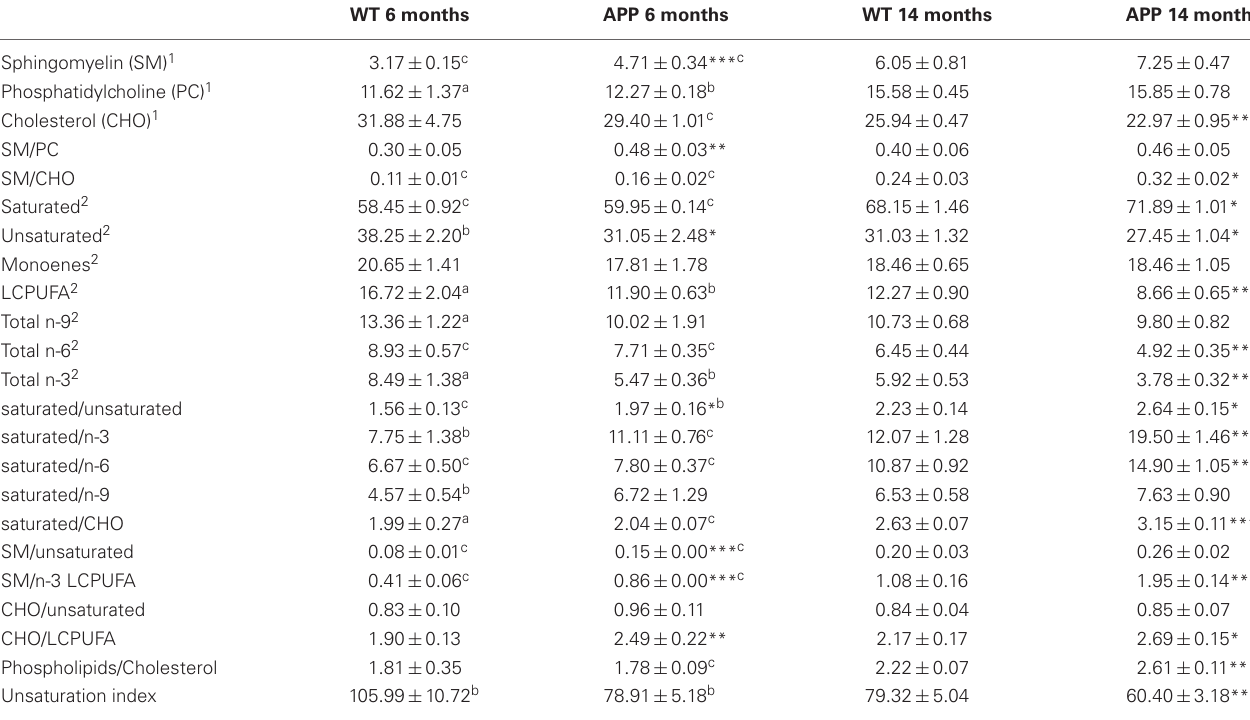
Data are expressed mean ± SEM for 4–5 animals in each group of genotype and age. 1 Weight percent respect to total lipids from lipid raft, 2 weight percent respect to total fatty acids from lipid raft. * , ** , ***Indicate statistical differences with p = 0.1, p = 0.05 and p = 0.01 between genotypes of same age. a , b , c Indicate statistical differences with p = 0.1, p = 0.05 and p = 0.01 between ages within each genotype.